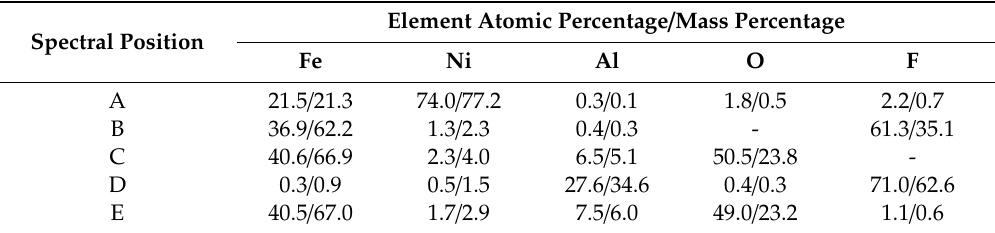
Figure 5. The SEM cross-section micrograph ( a ) and EDS mapping with respect to F ( b ), Fe ( c ), Ni ( d ), Al ( e ), and O ( f ) of 57.9Fe-38.2Ni-3.9Al alloy after electrolytic corrosion in 39.3NaF-43.7AlF 3 -8NaCl-5CaF 2 -4Al 2 O 3 at 850 °C for 5 h. Table 2. Elements compositions of the cross-section of 57.9Fe-38.2Ni-3.9Al alloy analyzed by EDS. Element Atomic Percentage / Mass Spectral Position